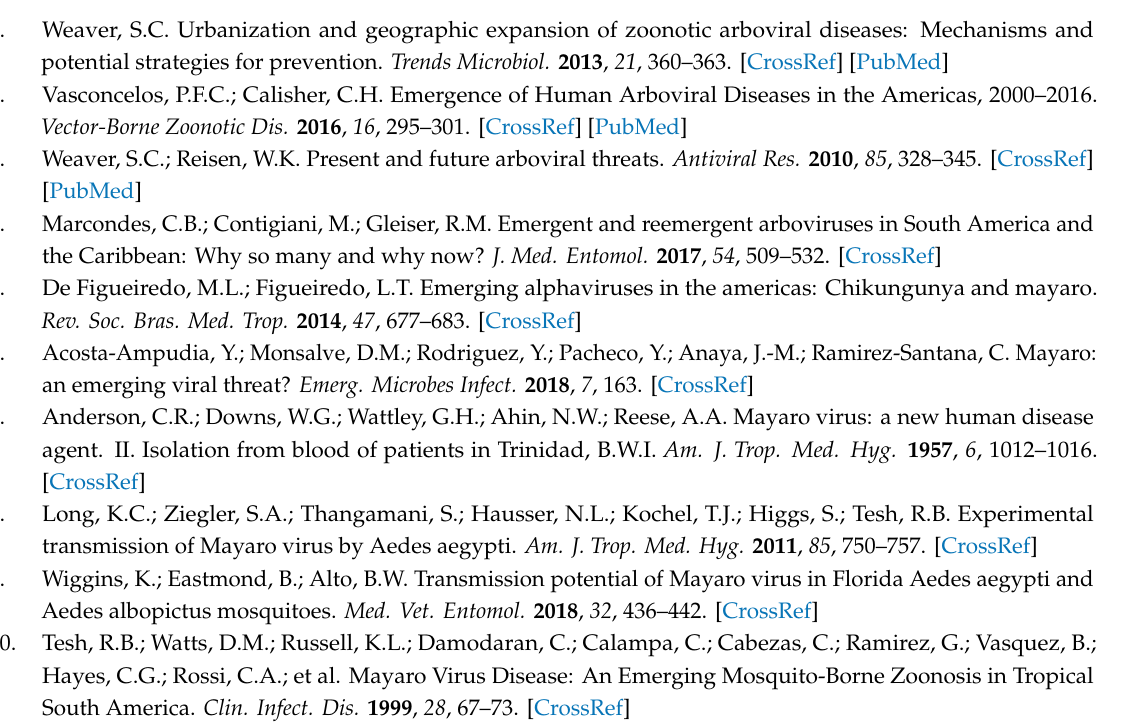
Figure S1: Proteasome inhibition promotes the accumulation of K48-polyubiquitinated proteins; Figure S2: Validation of purified antibodies against E1 and nsP1 proteins from MAYV; Figure S3: Proteasome inhibition a ff ects the synthesis of MAYV E1 and nsP1 proteins in HeLa cells; Figure S4: MAYV-purified antibodies recognize E1 and nsP1 from other MAYV-related Alphaviruses such as UNAV and